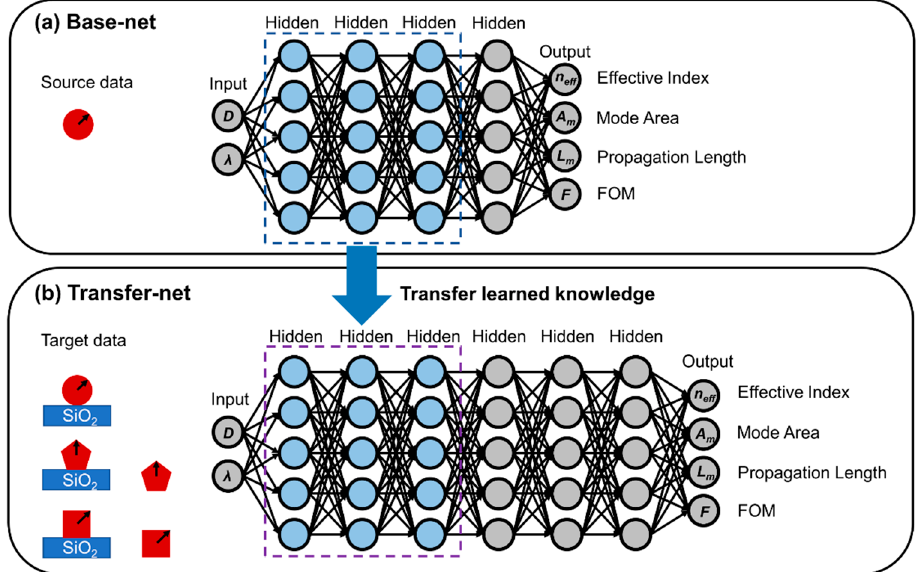
Figure 2. Schematic illustrations of the model architecture. ( a ) Base net and ( b ) transfer net based on ANN frameworks. The base net is used for gaining basic knowledge from free-standing circular MNWs, establishing the mapping from the input of diameters ( D ) and wavelengths ( λ ) to the output of effective index ( n eff ), mode area ( A m ), propagation length ( L m ), and figure of merit (FOM). The transfer net is used to deal with MNWs in complex configurations with abrupt geometric features (free-standing pentagonal and square MNWs) and broken symmetries (silica-substrate-supported circular, pentagonal, and square MNWs). Transfer learning is enabled by migrating learned knowledge (blue neuron nodes within dashed boxes) from the trained base net to the transfer net. The blue rectangles (SiO 2 ) represent the silica substrates. The red circles and polygons represent MNWs with different cross-sectional shapes. The diameters D of circles/polygons are defined as twice the radii/circumradii (indicated by the black arrows).